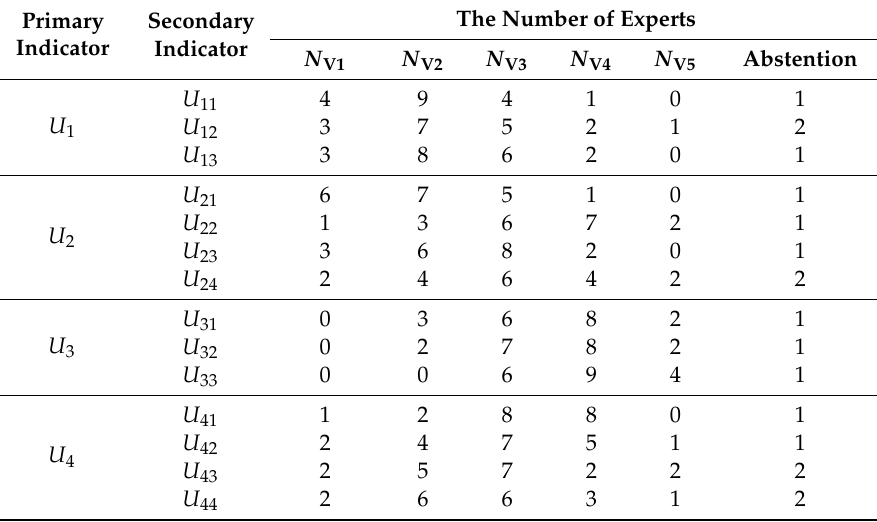
Table A3. Expert evaluation results of secondary